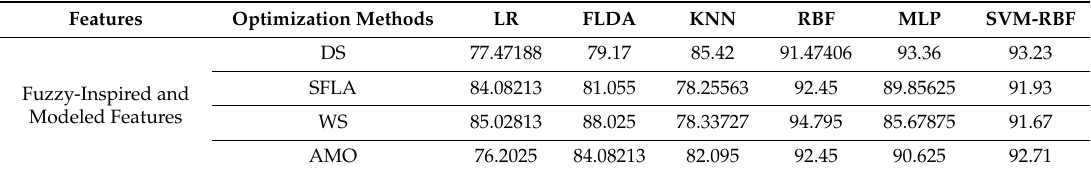
Table 10. Consolidated results of accuracy (%) among the classifiers at various optimization techniques with di ff erent features for normal